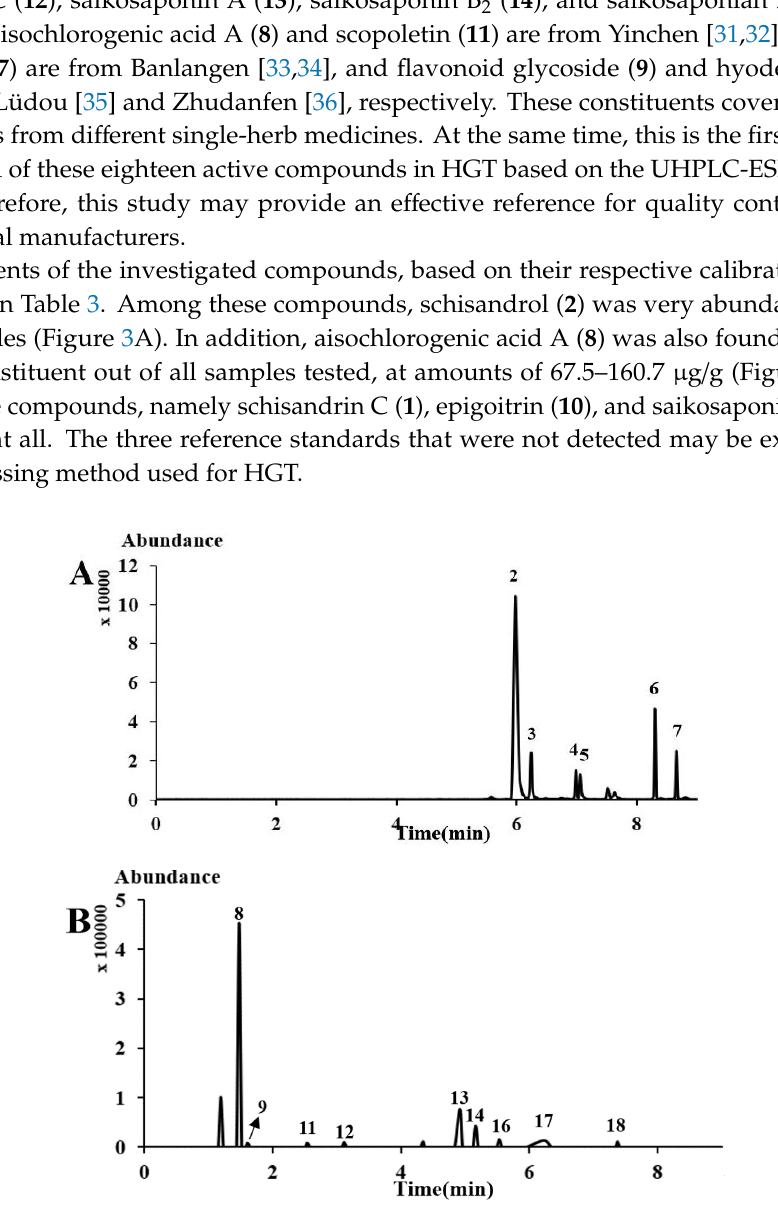
Figure 3. Typical multiple reaction monitoring (MRM) chromatograms of sample 6 in ( A ) positive mode and ( B ) negative mode. Table 3. Contents (μg/g) of 18 marker compounds in 8 different batches of Hu Gan tablets.